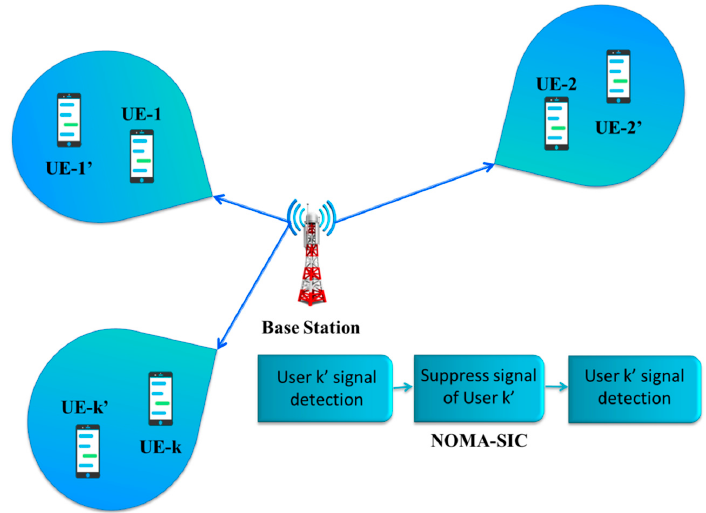
Figure 11. A MIMO-NOMA system with multiple clusters [166].